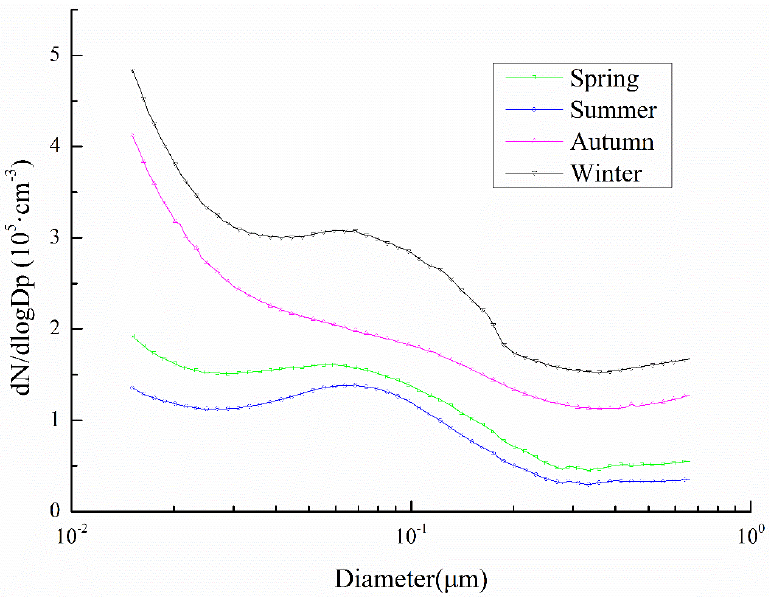
Figure 2. Number size distribution of fine particles in four seasons.